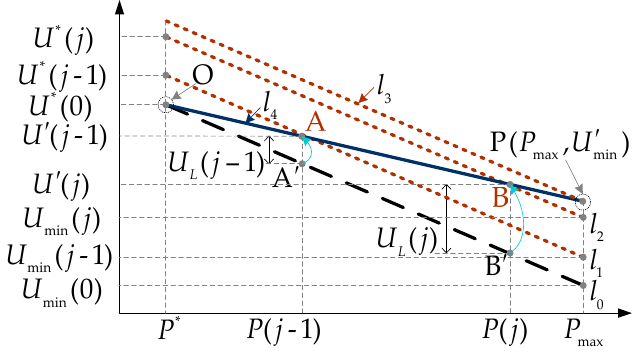
Figure 3. CVAR-based voltage droop features of DG.